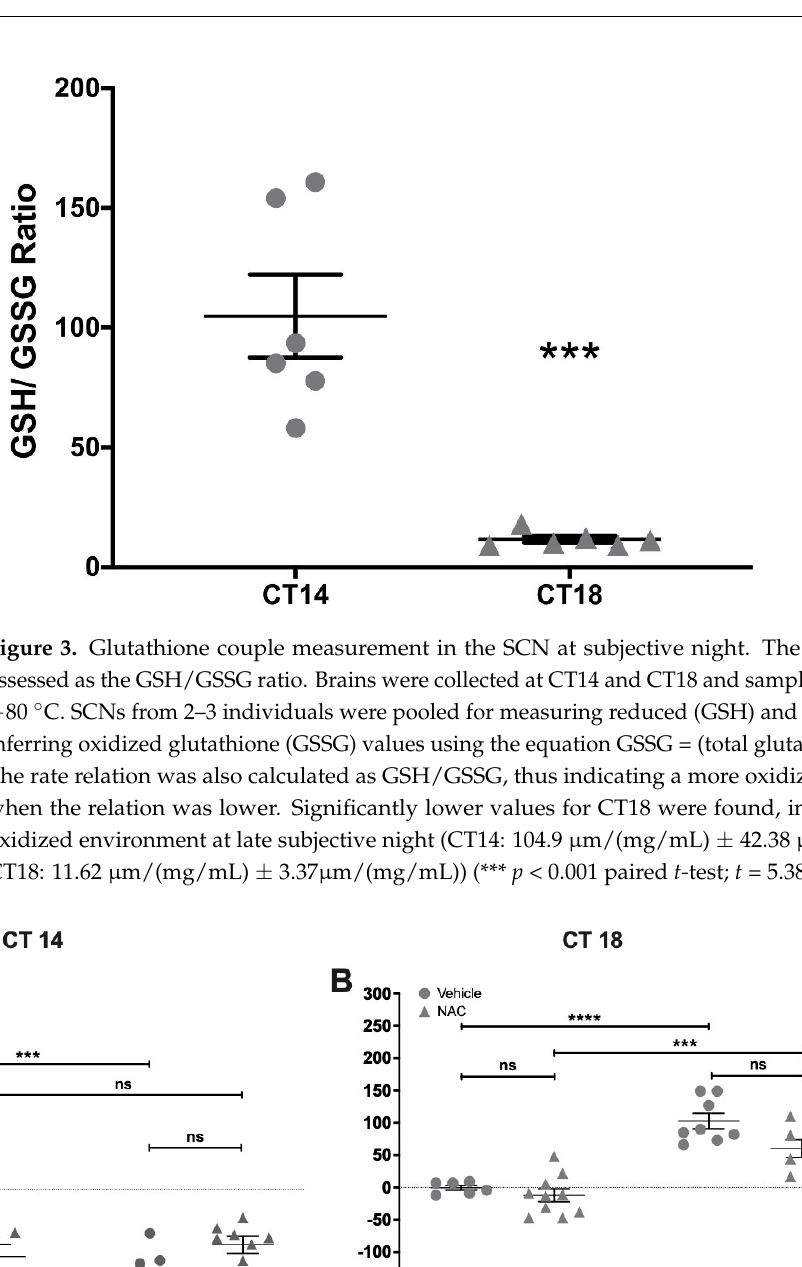
6 of 14 μ M solution at 1.5 μ L/min rate (grey boxes). Filled arrows indicate the time of injection with 400 pmol and 800 pmol of AS which corresponds with the registration of the baseline current, while dotted arrows indicate maximum current, which correlates to maximum HNO production. ( B ) Delta current values, calculated as the difference between maximum post-injection and basal prior-injection current values, for 400 pmol and 800 pmol AS. n = 4; * p < 0.05, paired t- test. 2.3. Measurement of the Redox Pair GSH–GSSG at the SCN Since HNO generated by AS may be favored under a reductive environment [33], the GSH/GSSG couple was measured at CT14 and CT18 in SCN tissue homogenates as a reli- able measure of the cellular redox state [34]. We found a significant difference in total GSH between CT14 and CT18 (10.29 μ m/(mg/mL) ± 3.99 μ m/(mg/mL) vs. 16.42 μ m/(mg/mL) ± 6.89 μ m/(mg/mL), respectively) ( p < 0.05 paired Student’s t- test; t = 2.43; df = 18; n = 6). When GSH was analyzed, we found no significant differences (CT14: 8.73 μ m/(mg/mL) ± 3.30 μ m/(mg/mL) vs. CT18: 9.98 μ m/(mg/mL) ± 3.91 μ m/(mg/mL)). Nevertheless, GSSG was significantly higher at CT18 when compared with CT14 (CT14: 0.13 μ m/(mg/mL) ± 0.11 μ m/(mg/mL) vs. CT18: 0.58 μ m/(mg/mL) ± 0.31 μ m/(mg/mL)) ( p < 0.01 paired t test; t = 3.99; df = 15; n = 6), indicating a more oxidized state at CT18 in the SCN. This was con-